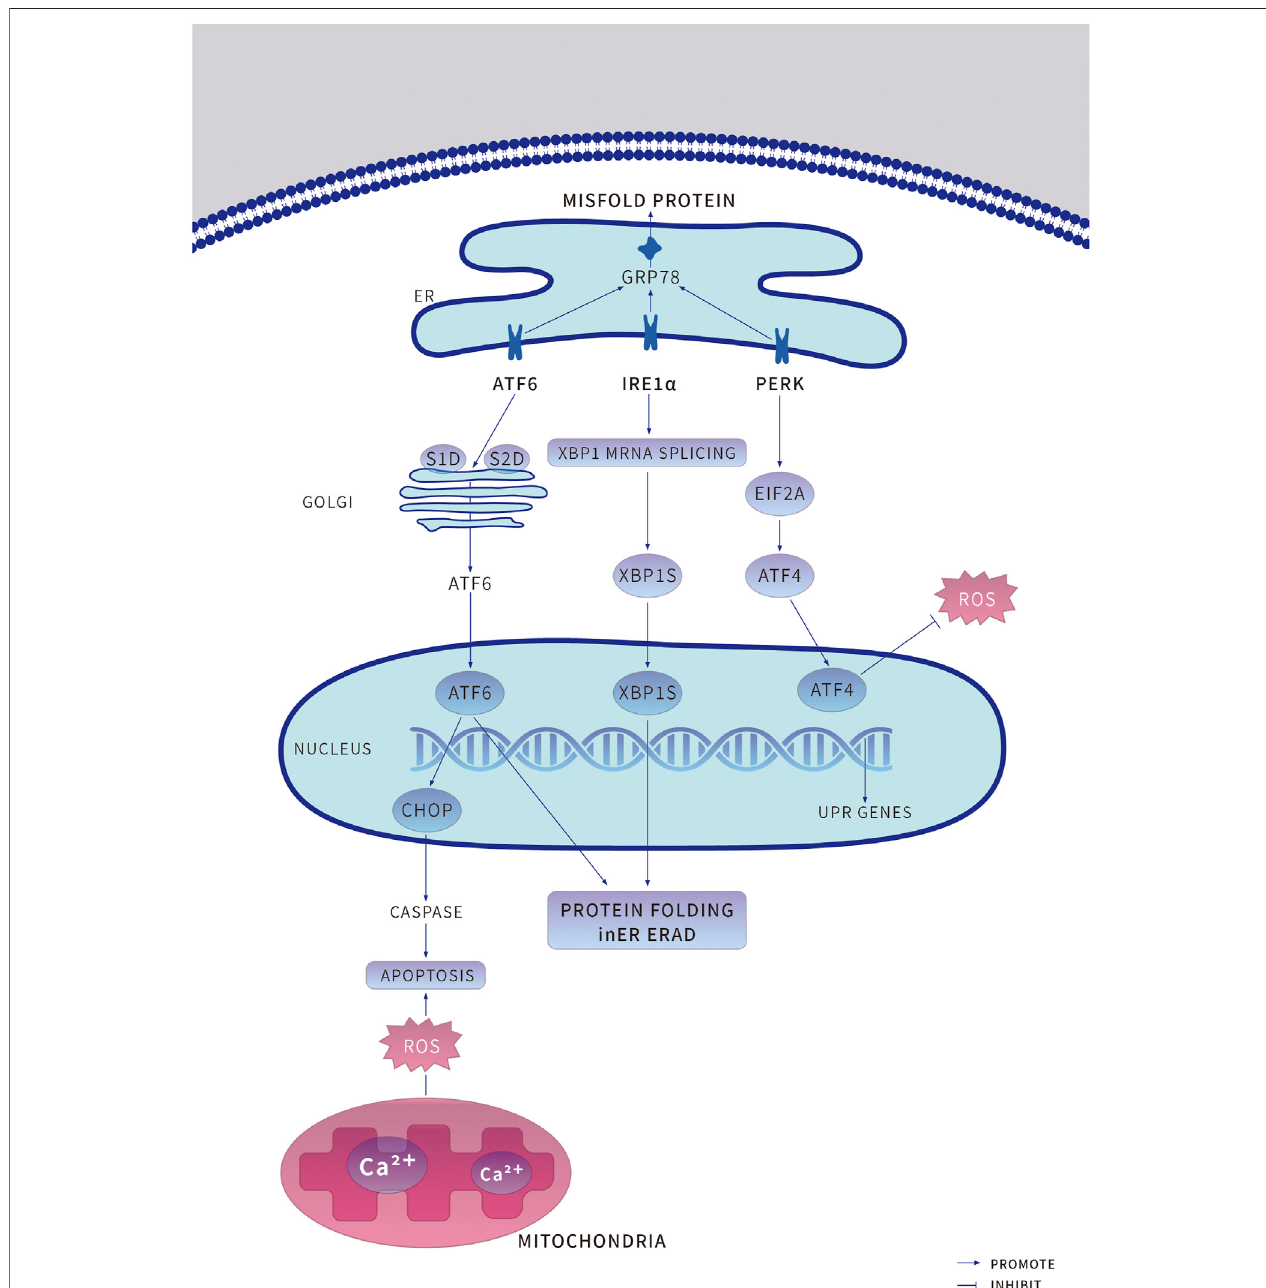
FIGURE 1 | Under endoplasmic reticulum (ER) stress, the adaptive unfolded protein response (UPR) is induced to preserve protein homeostasis and to promote cell survival. An increased accumulation of unfolded or misfolded proteins causes the ER chaperone binding immunoglobulin protein (GRP78) to bind to misfolded proteins accumulated in the ER, resulting in the release of the UPR sensors protein kinase RNA-like ER kinase (PERK), Transcriptional transcription factor 6 (ATF6) and inositol-requiring protein 1 α (IRE1 α ) and initiation of the respective proteins dimerization and phosphorylation of PERK and IRE1 α activate their downstream pathways,PERK--phosphorylatedEukaryoticInitiationfactor2 α .Eukaryoticinitiationfactor2A(EIF2A)--ATF4andIRE1 α --SplicedX-box-bindingprotein1(XBP1s),to promotecellsurvival.ATF6isrecruited totheGolgiapparatusforprocessingbytheenzymessite-1proteases (S1P)andsite-1proteases(S2P)toreleasecleavedATF6, which enters the nucleus to induce the expression of target genes to promote cell survival. ERAD, ER-associated degradation; ROS, reactive oxygen species.